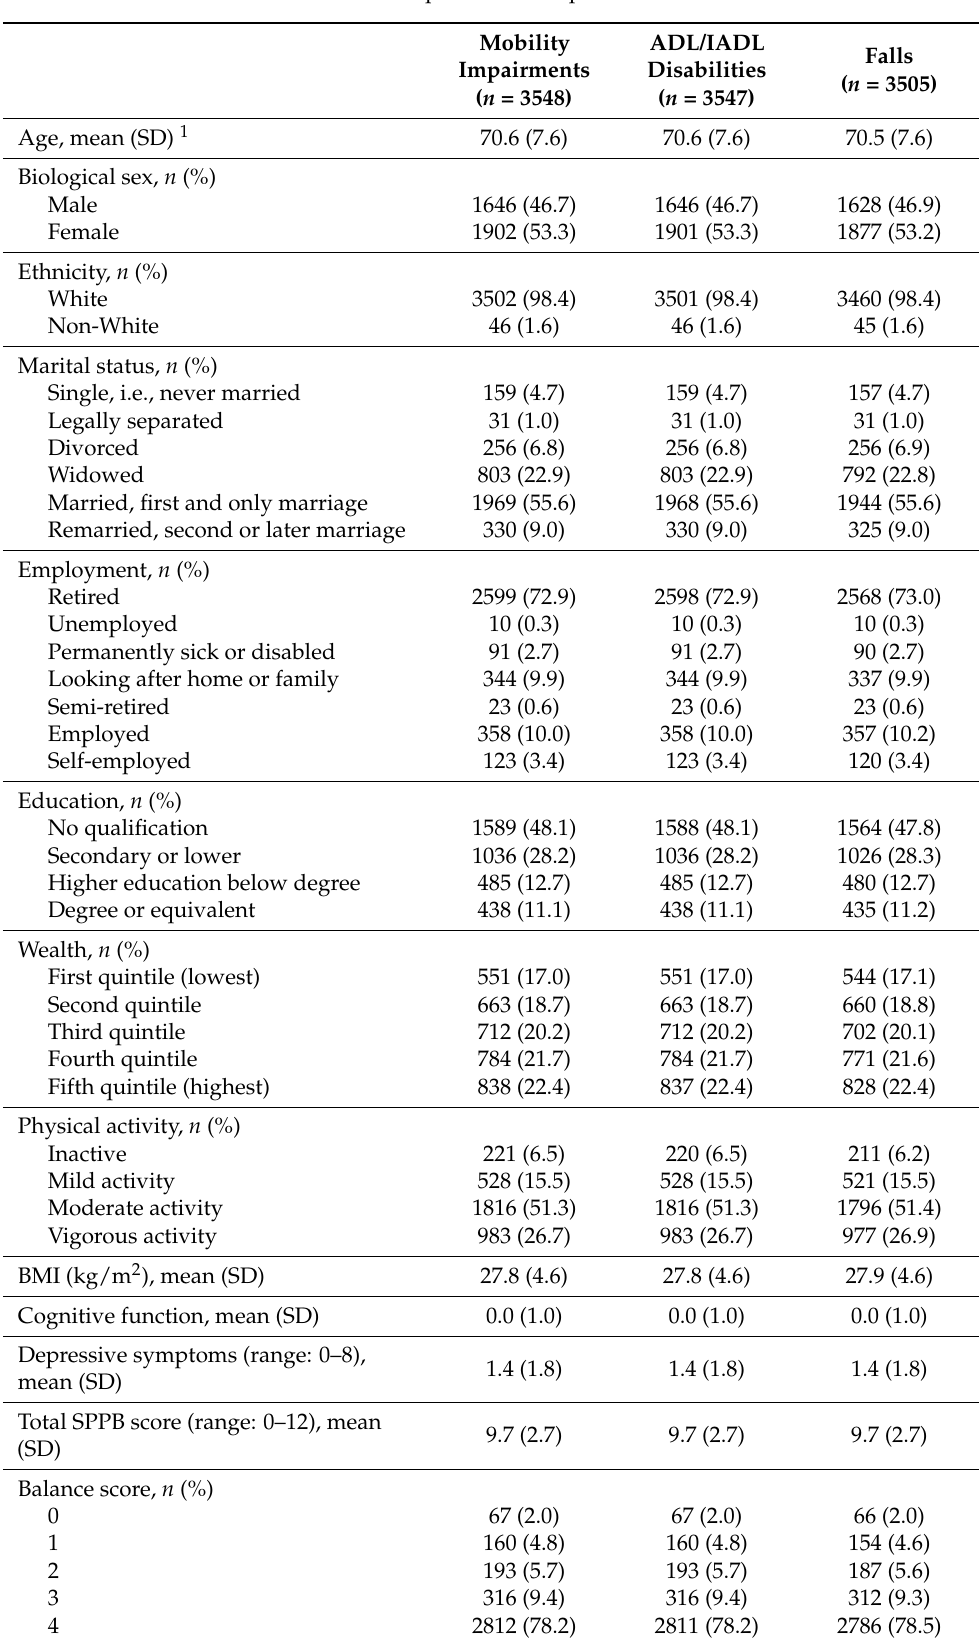
Table 1. Baseline characteristics of the complete-case